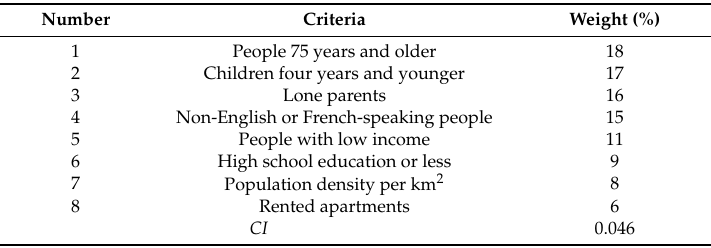
Figure 8. Total vulnerability for each scenario; ( a ) V1; ( b ) V2; and ( c ) V3. Table 11. Weights of social vulnerability criteria.